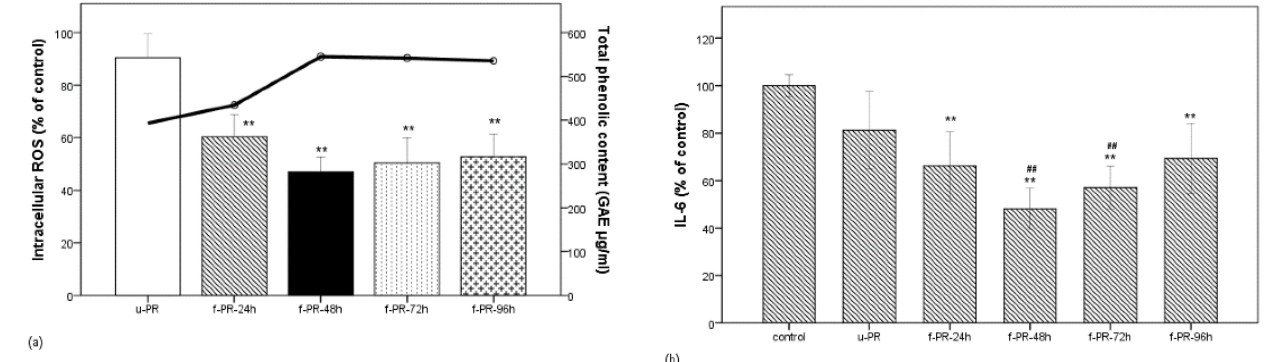
Figure 1. Correlation between phenolic compound content and bioactivity of the PR extracts fermented for the given times. ( a ) Correlation between phenolic content (line) and the intracellular ROS level (bar) in the unfermented PR extract and the PR extract fermented for 24, 72, or 96 h in the LPS-stimulated RAW 264.7 macrophage cells; ( b ) IL-6 level (in % of control) under the same condition as ( a ). Data are expressed as the mean value of at least triplicate experiments. Error bars represent +/ − standard deviation. ** p < 0.01 versus control, ## p < 0.01 versus u-PR. u-PR: PR extract without fermentation; f-PR-24h, f-PR-48h, f-PR-72h, and f-PR-96h: PR extract after fermentation for 24, 48, 72, and 96 h, respectively.